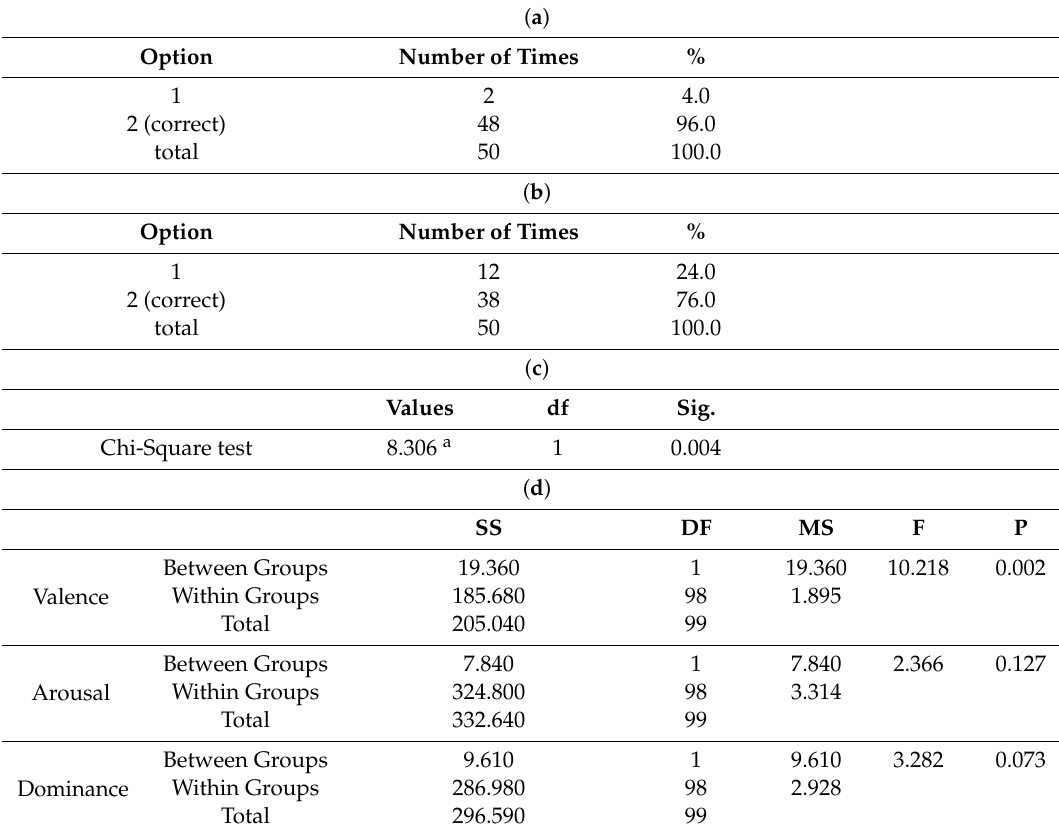
Table 2. ( a ) Estimation of material with the physical product. ( b ) Estimation of material with the